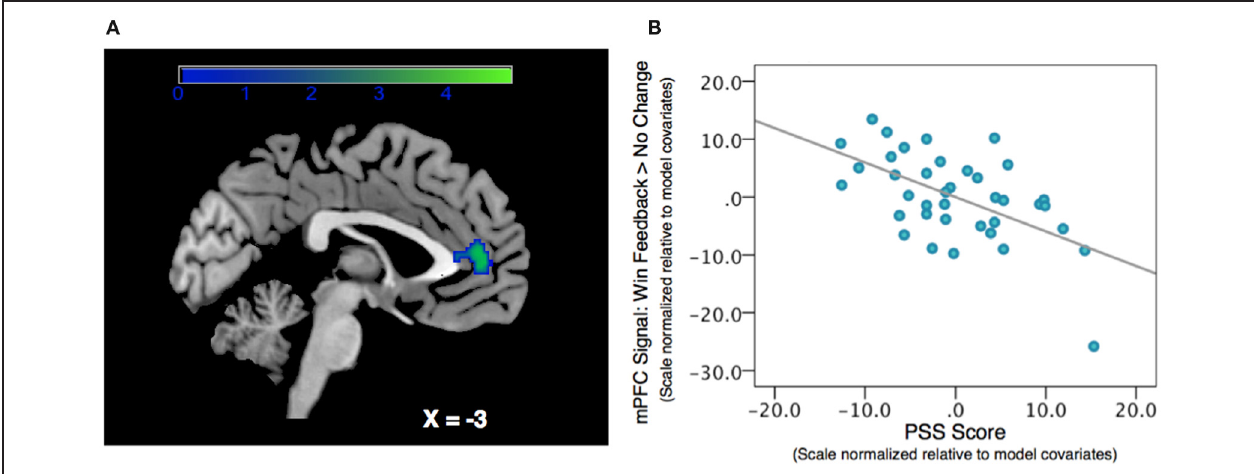
FIGURE 2 | Association between Perceived Stress and mPFC BOLD signal during a contrast of Win Feedback > No Change Feedback. (A) SPM depicting mPFC cluster. Cluster is significant after correcting for multiple-comparisons using a cluster-extent correction procedure p cluster = 0 . 023. Color-bar indicates t -statistic. (B) Partial regression plot,